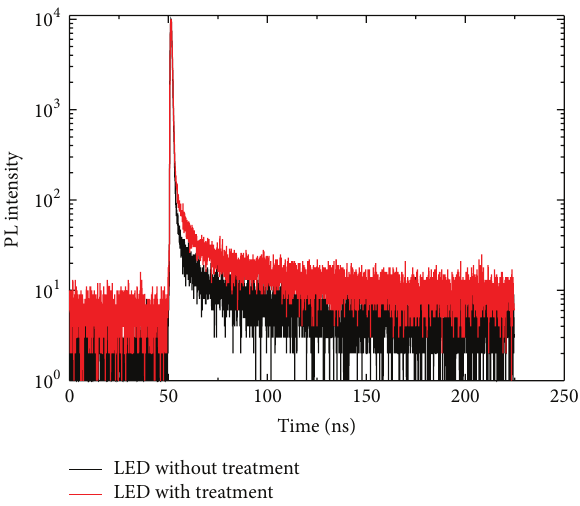
Figure 6: Time-resolved photoluminescence decay profiles of the LEDs prepared with and without TMIn treatment.